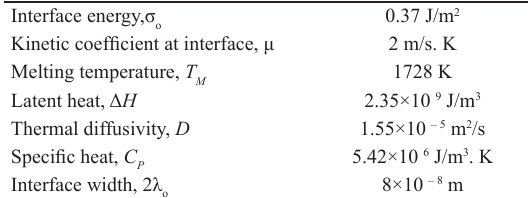
Table 2. Material properties of Ni 8 .